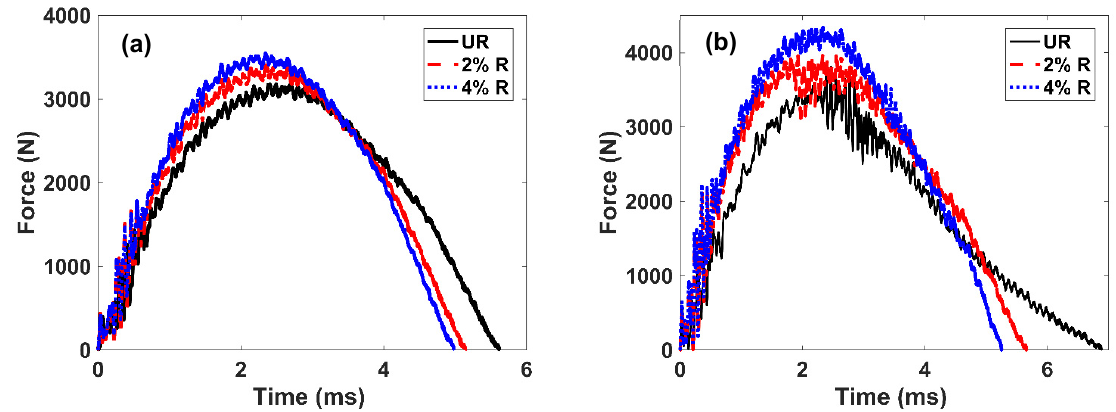
Figure 1. Force time histories at ( a ) the 7.5 J loading and ( b ) the 12.5 J loading. Table 1. Low-velocity impact and post-impact flexural characteristic